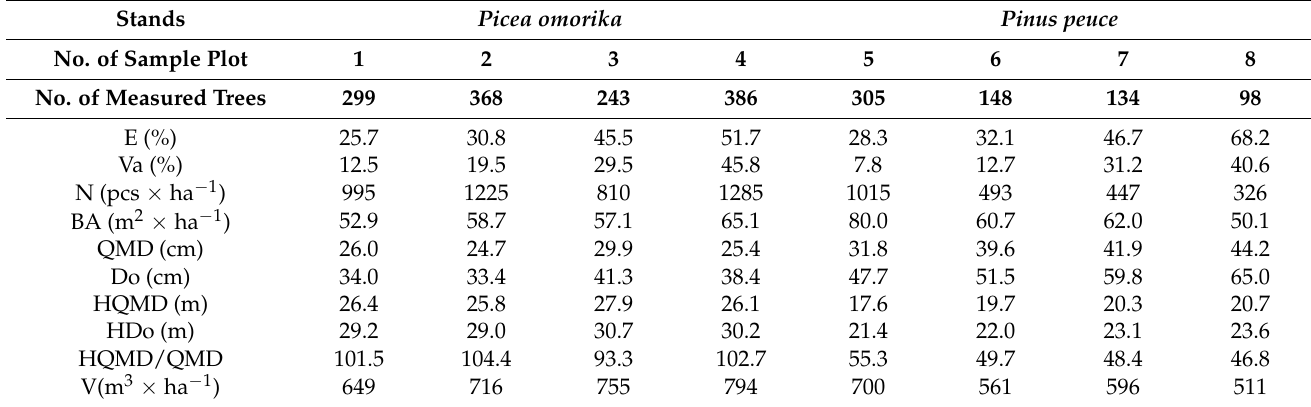
Table 2. Basic numerical characteristics of the sample plots.